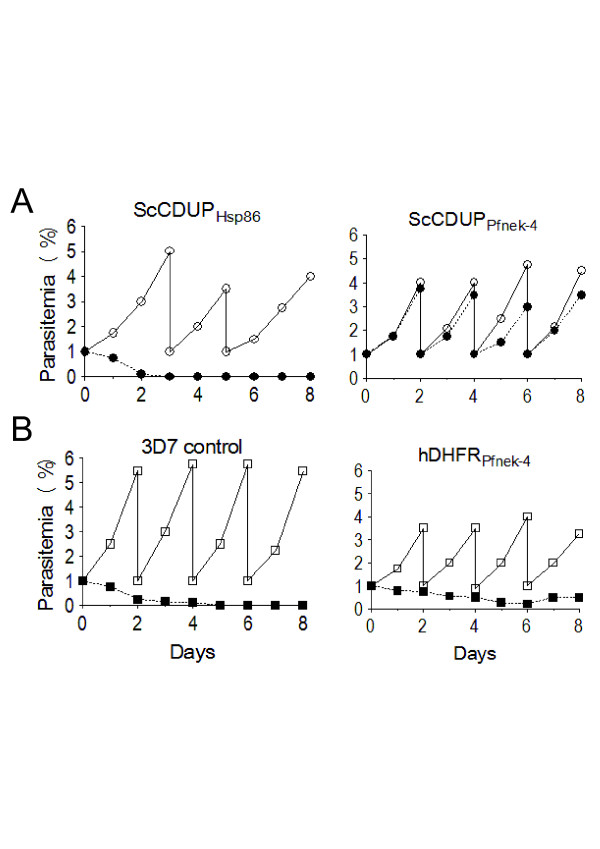
Selection of parasite transfectants expressing negative or positive selectable markers directed by Pfnek-4 promoter.A, In vitro growth rate of 3D7 parasite transfectants expressing the Saccharomyces cerevisiae cytosine deaminase-uridylphosphoribosyltransferase fusion gene (ScCDUP) driven by Hsp86 (pScCDUPHsp86) or Pfnek-4 (pScCDUPPfnek-4) 5’ flanking regions, in presence (●) or absence (○) of prodrug 5-FC (1 μM). B, In vitro growth rate of untransformed 3D7 (3D7 control) and 3D7 parasite transfectants expressing the human dihydrofolate reductase (hDHFR) gene driven by Pfnek-4 5’ flanking region (phDHFRPfnek-4), in presence (■) or absence (□) of WR22910 (5 nM). Parasitaemia (mean of duplicate cultures) were determined daily by Giemsa-stained blood smears and parasite cultures >3% parasitaemia were diluted to 1%-parasitaemia.